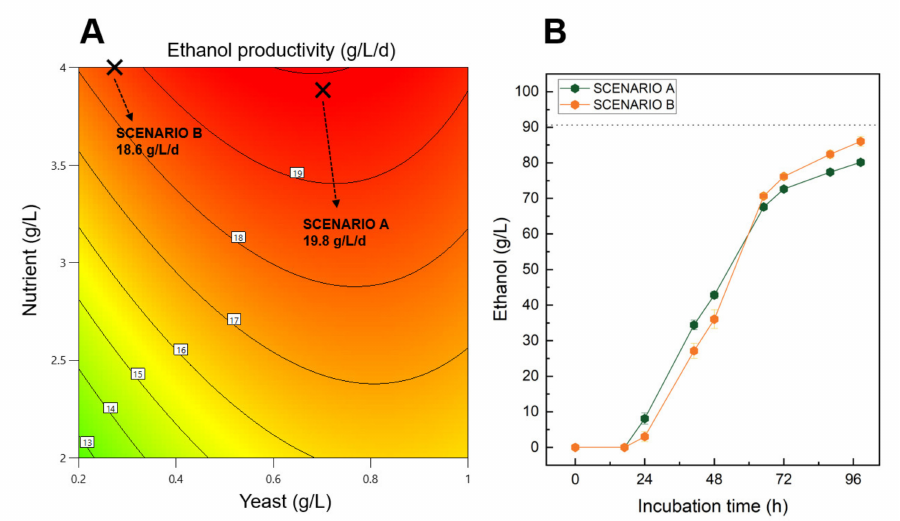
Figure 5. ( A )—Isoresponse curves predicting the ethanol productivity responses based on nutrient and yeast concentrations using non-treated sugar beet molasses diluted at 170 g/L of initial sugar. ( B )—Experimental fermentation kinetics of the two investigated scenarios for an initial sugar con- centration of 170 g/L. Both scenarios A and B were designed for maximizing ethanol productivity with a high (0.7 g/L) and low concentration (0.27) of yeast, respectively. In addition, 3.9 and 4.0 g/L of nutrient were respectively used for scenario A and B. The dashed line represents the theoretical maximum ethanol yield of both